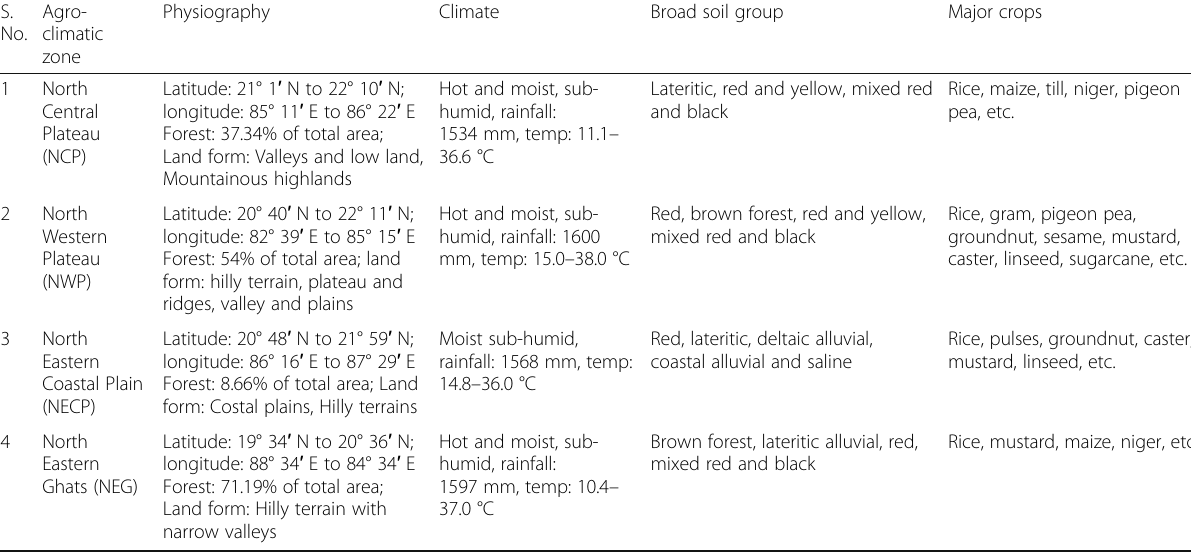
Table 1 Physiography, climate, broad soil group, and cropping pattern of study area S. Agro- Physiography Climate Broad soil group Major No. climatic zone